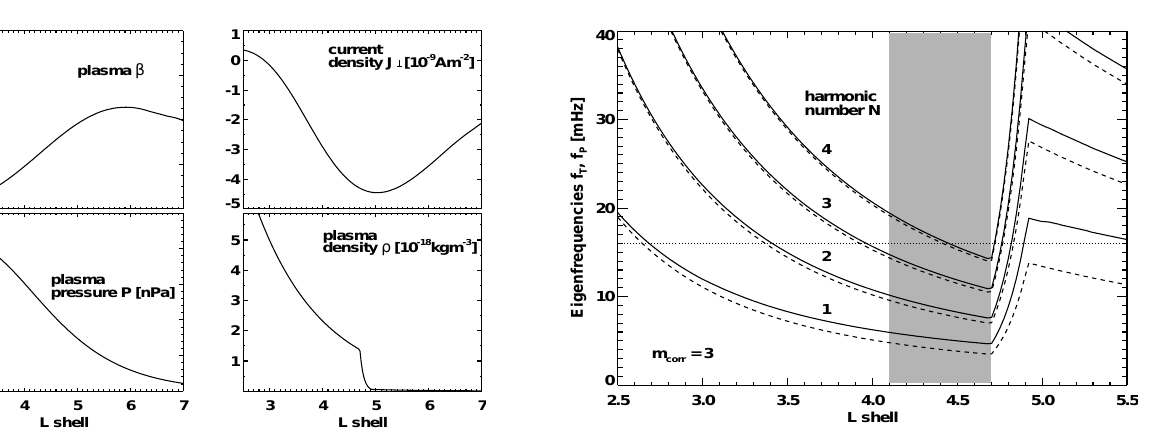
Fig. 9. Profiles of plasma properties. Plasma pressure and plasma β are assumed for quiet geomagnetic activity (Lui and Hamilton, 1992). The current density is obtained from the Tsyganenko ’96 model. Positive values of J ⊥ correspond to a current directed east- ward. The plasma density is calculated from modeling the electron number density (Carpenter and Anderson, 1992).